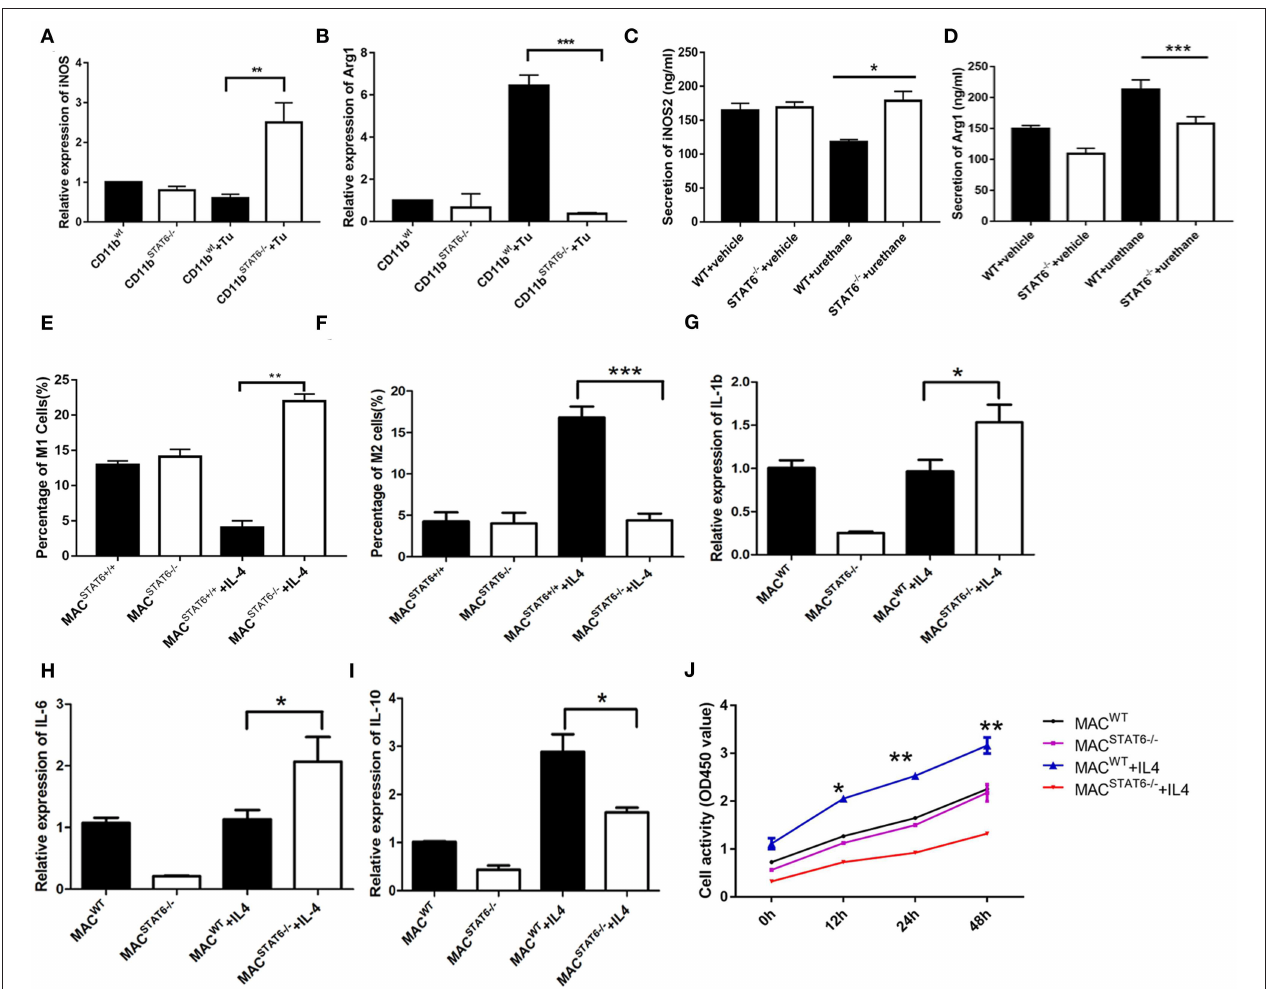
FIGURE 8 | Cytokines play a role in signal transducer and activator of transcription 6 (STAT6) − / − -mediated macrophage polarization. (A) Relative mRNA expression of iNOS in CD11b + cells when cocultured with LLC1 cells. (B) Relative mRNA expression of Arg1 in CD11b + cells when cocultured with LLC1 cells. (C,D) Expression of iNOS and Arg1 in groups of wild type and STAT6 − / − mice. (E) Percentage of M1 cells in bone marrow-derived macrophages after 7 days of culture with 10ng/ml exogenous interleukin (IL)-4. (F) Percentage of M2 cells in bone marrow-derived macrophages after 7 days of culture with 10ng/ml exogenous IL-4. (G) Relative mRNA expression of IL-1 β in bone marrow-derived macrophages after 7 days of culture with 10ng/ml exogenous IL-4. (H) Relative mRNA expression of IL-6 in bone marrow-derived macrophages after 7 days of culture with 10ng/ml exogenous IL-4. (I) Relative mRNA expression of IL-10 in bone marrow-derived macrophages after 7 days of culture with 10ng/ml exogenous IL-4. (J) LLC1 cells (lower plates) were cocultured with macrophages (upper plates) using Transwell plates. Cell proliferation of LLC1 cells was analyzed by CCK8 with or without stimulation by exogenous IL-4. * P < 0.05, ** P < 0.01, *** P <